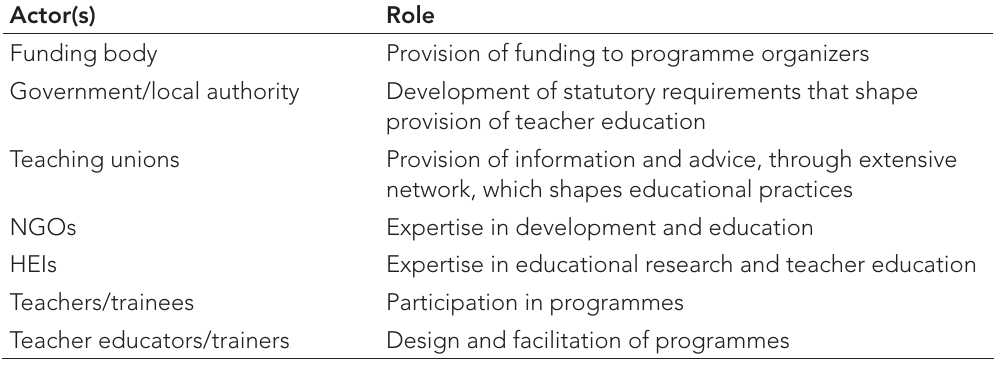
Table 1: The roles of actors involved in GCE teacher education